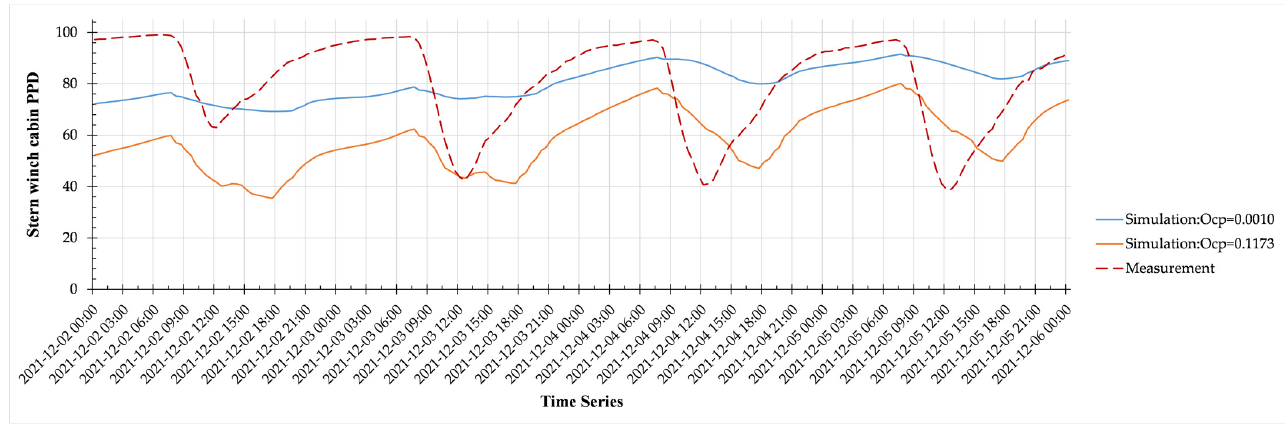
Figure B3. Stern winch cabin: predicted mean vote between 2 and 5 December 2021